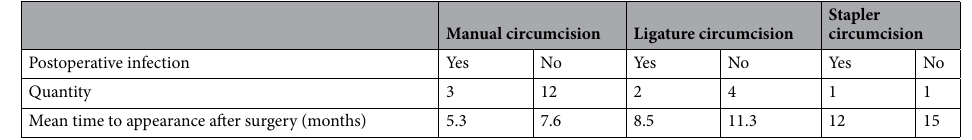
Table 7. The appearance time of postoperative wound infection and secondary epidermoid cysts of the penis. Among the 23 surgical patients, 26.1% had postoperative infection, and 73.9% had non-surgical infection. Statistical analysis of postoperative infection was performed according to the surgical procedure. Whether the same or different surgical procedures were compared, the presence of postoperative wound infection accelerated the appearance of secondary epidermoid cysts of the penis.